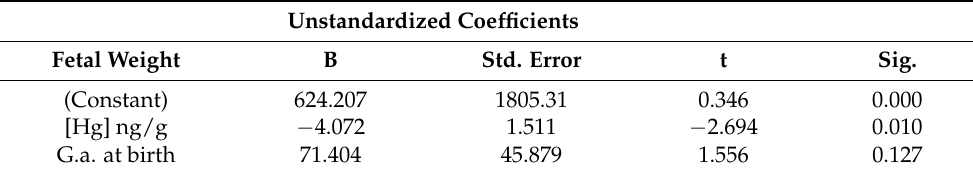
Table 7. Estimations of the parameters of the simple linear regression model in the concentrations of Hg in the placenta as a function of the fetal weight in the female